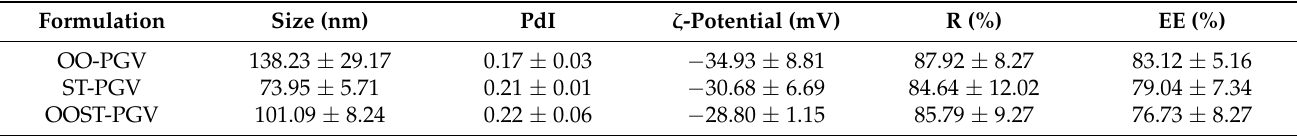
Table 4. Physical and chemical parameters of propylene glycol-nanovesicles loaded with: O. onites essential oil (OO-PGV), S. thymbra essential oil (ST-PGV), O. onites plus S. thymbra essential oils (OOST-PGV). From left: Size, polydispersity index (PdI), ζ -potential, recovery (R) and encapsulation efficiency (EE); mean ± SD ( n = 3). Formulation Size (nm) PdI OO-PGV ST-PGV 73.95 ± 5.71